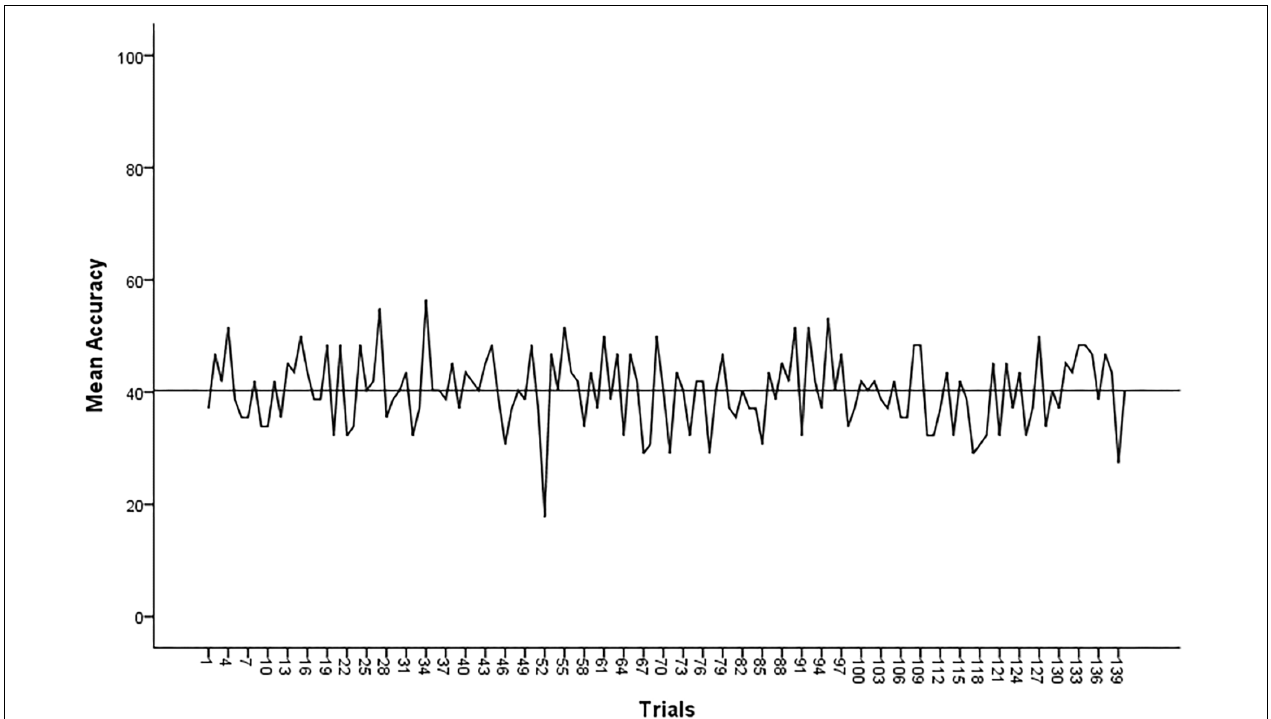
FIGURE 4 | Accuracy average compiled for experimental task